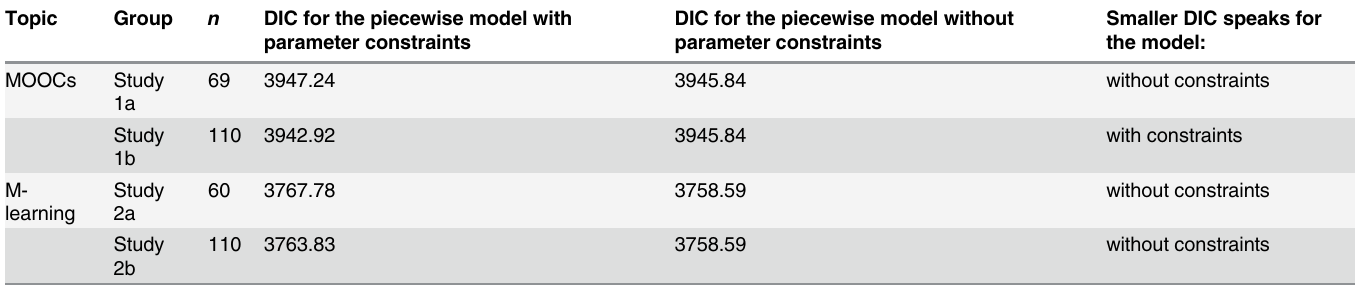
Table 2. Model comparisons (model with parameter constraints: β 10 and β 20 as well as β 11 and β 21 are held equal) with the deviance information criterion